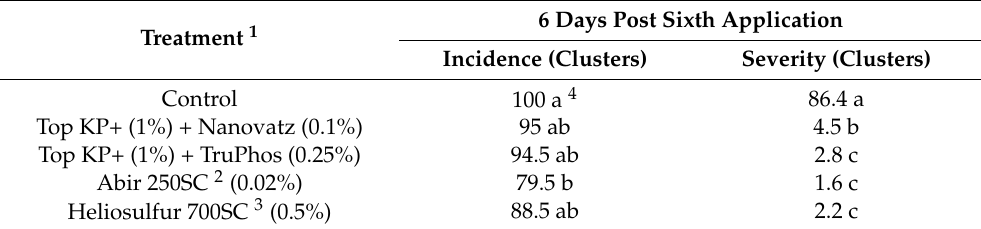
Table 1. Efficacy of nutrients and fungicides in controlling powdery mildew on the clusters of Vitis vinifera cv. Cabernet Sauvignon at Merom-Golan vineyard (trial 1), 2018.